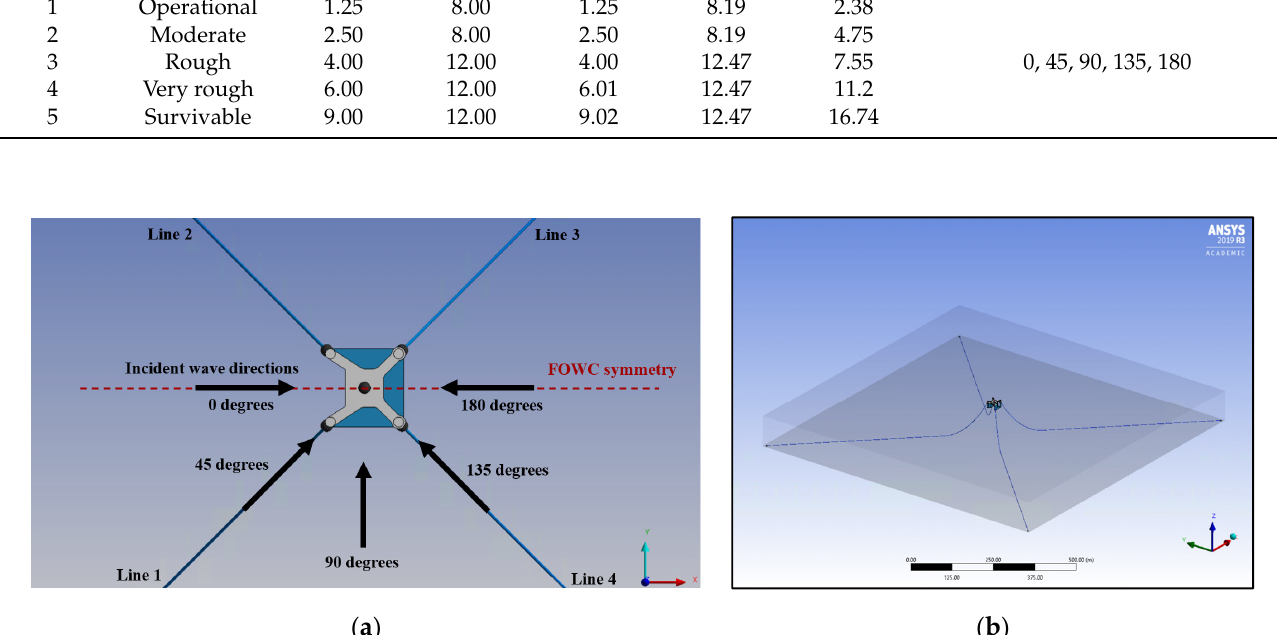
Figure 11. ( a ) Plan view of the FOWC with mooring arrangement and incident wave directions, ( b ) three-dimensional representation of the mooring arrangement. Table 8. Sea-state conditions for the FOWC mooring study.